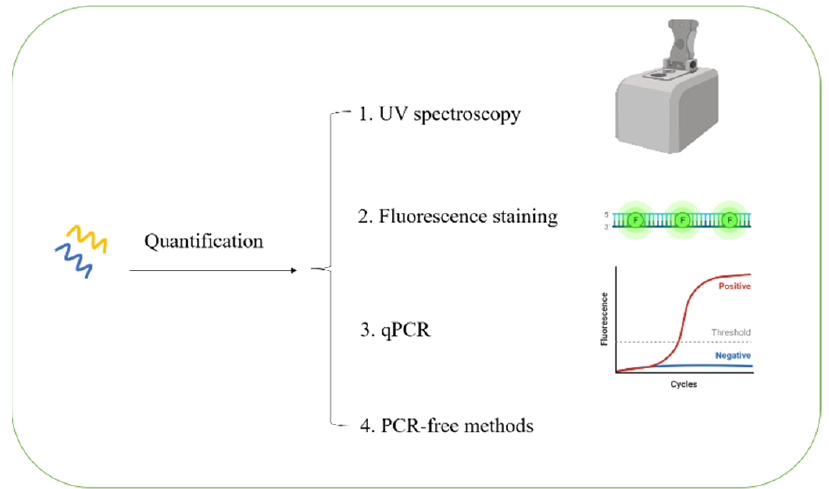
Figure 5. The methods of eDNA quantification. qPCR: quantitative PCR. There are four methods for eDNA quantification. Instrument in the upper right corner means the UV spectrophotometer for quantifying eDNA. The green circle represents fluorescent